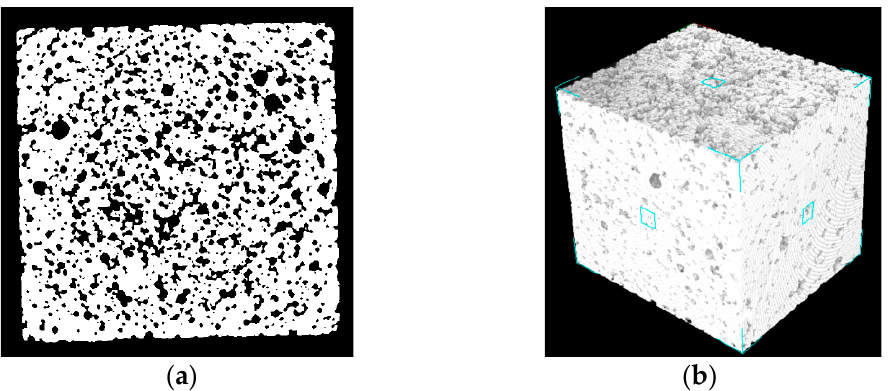
Figure 6. ( a ) The grayscale image of the CT slice, ( b ) 3D reconstruction of the pore structure.